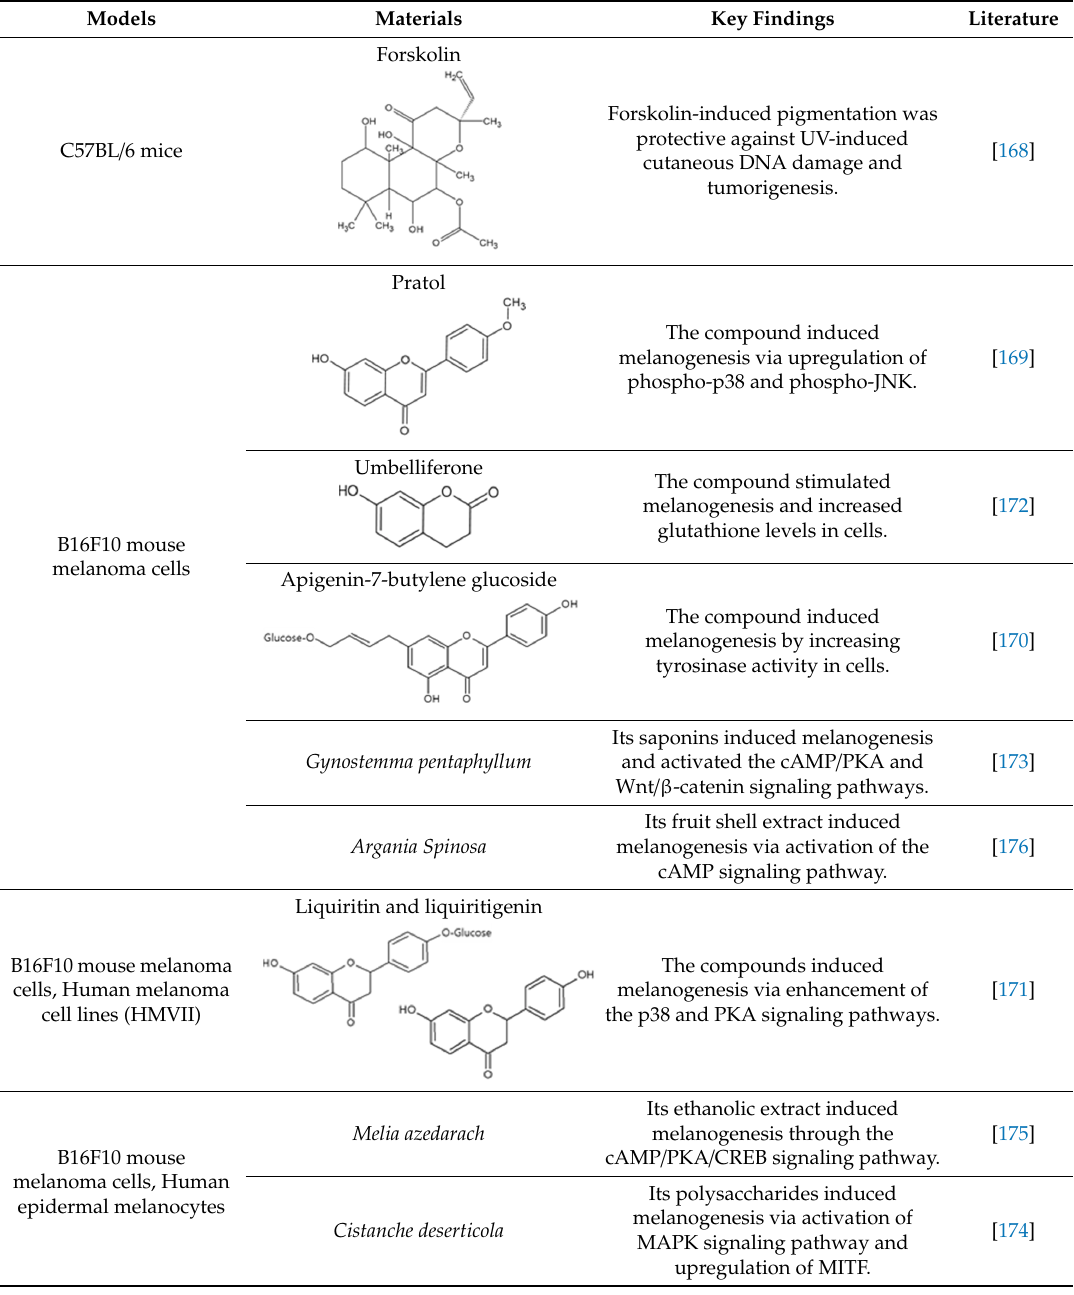
Table 4. Induction of melanogenesis by plant-derived materials.